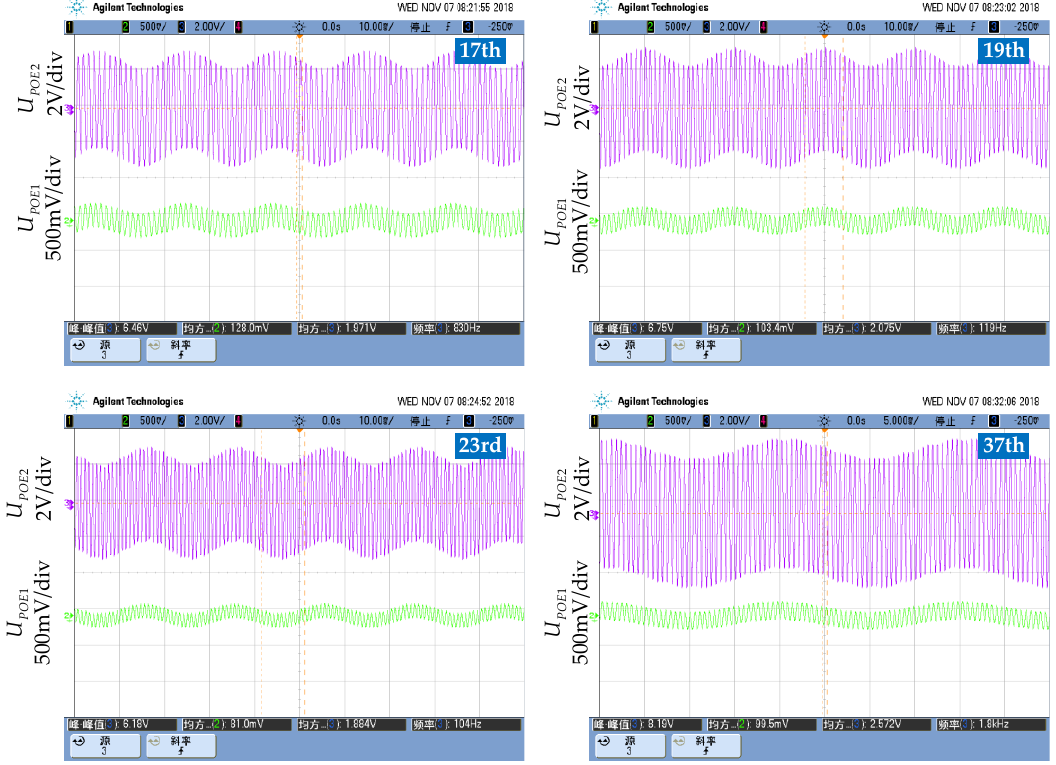
Figure 16. Experimental results of harmonic voltage at the POE1 and POE2 (17 th , 19 th , 23 rd , and 37 th harmonic).